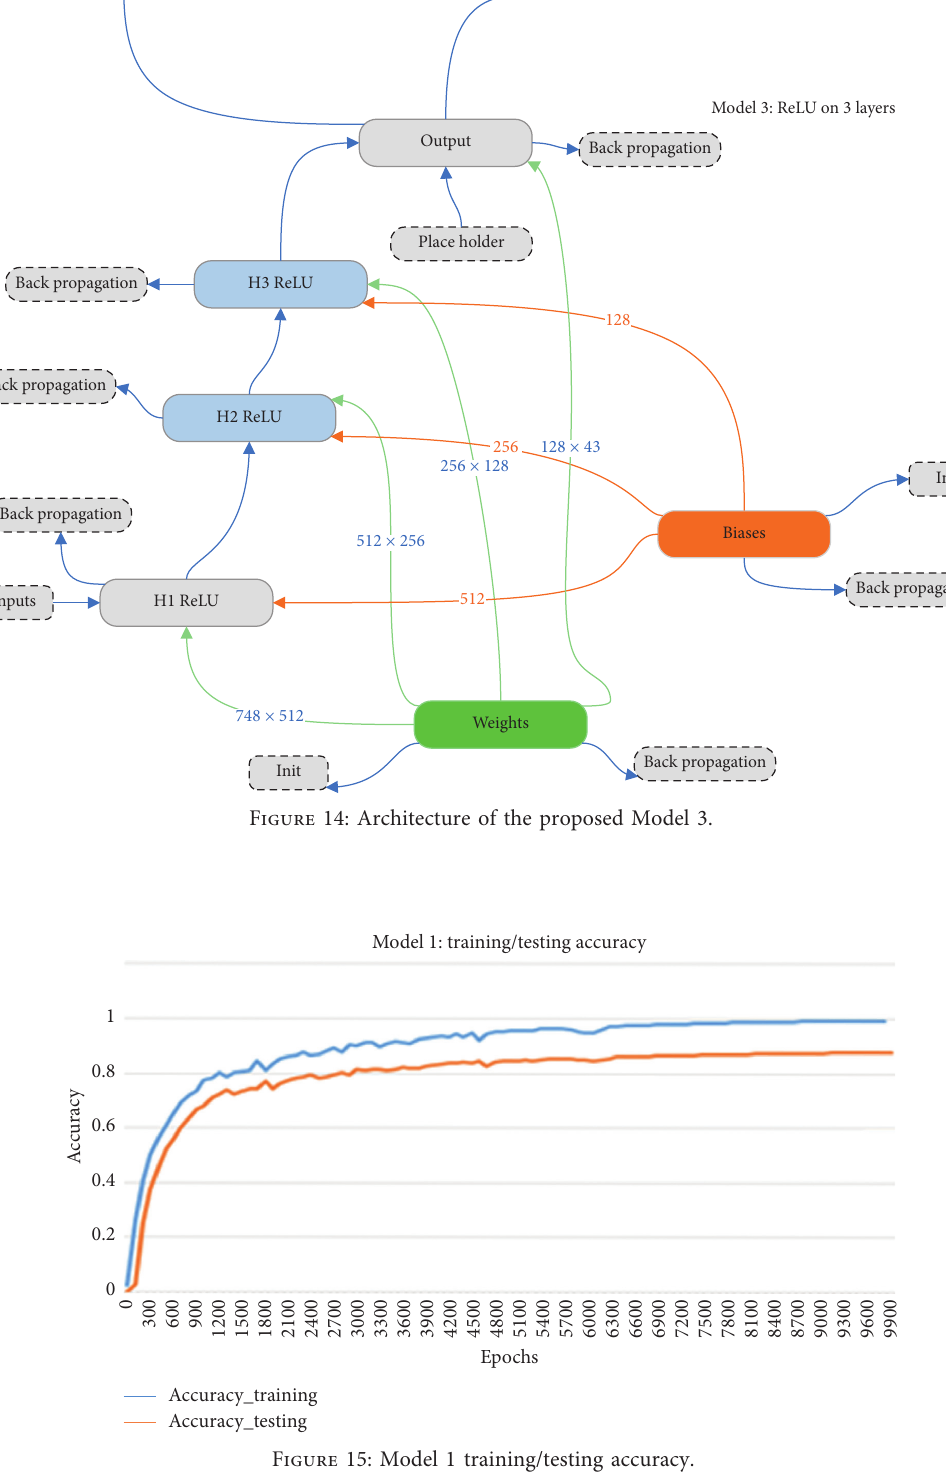
Figure 15: Model 1 training/testing